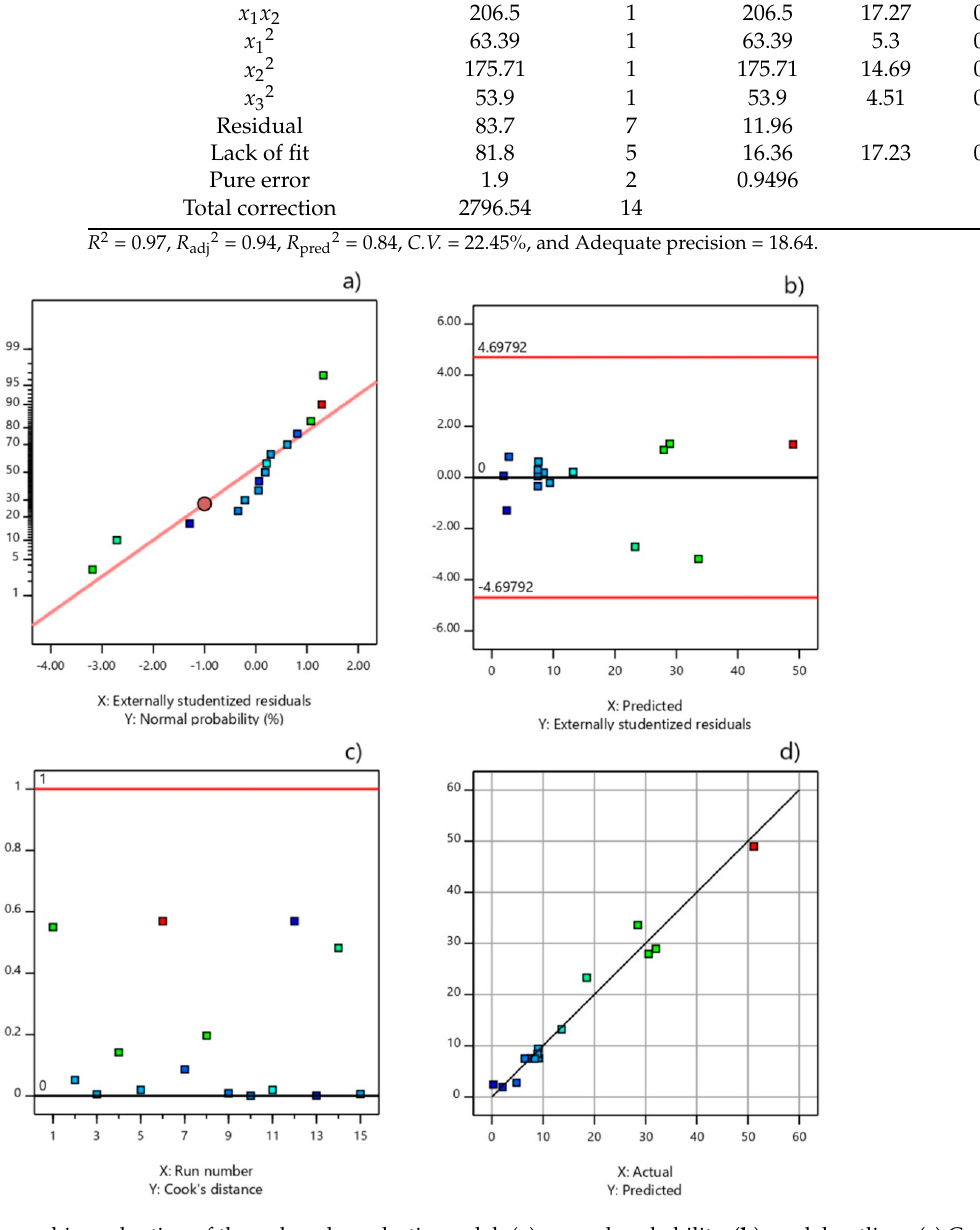
Figure 8. Statistical graphic evaluation of the reduced quadratic model: ( a ) normal probability, ( b ) model outliers, ( c ) Cook’s distance, and ( d ) actual and predicted fatty acid methyl esters (FAME) content plot.